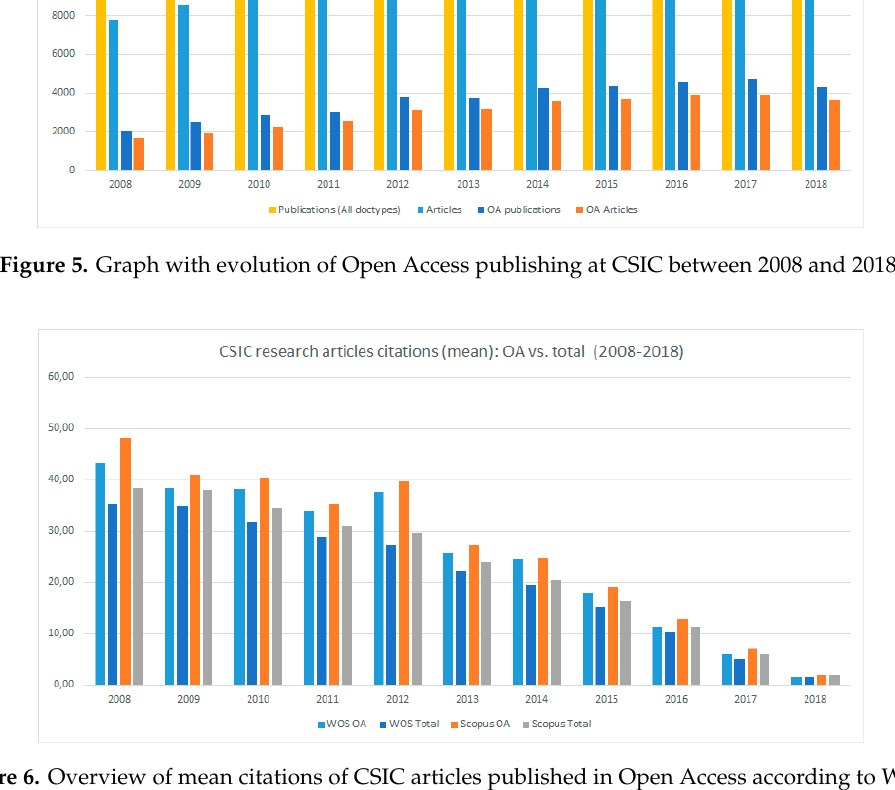
Figure 6. Overview of mean citations of CSIC articles published in Open Access according to Web of Science (WoS) and Scopus. Comparison with mean citations of total CSIC research articles. Table 2. Mean citations (values) of CSIC articles published in Open Access according to WoS and Scopus. Comparison with mean citations of total CSIC research